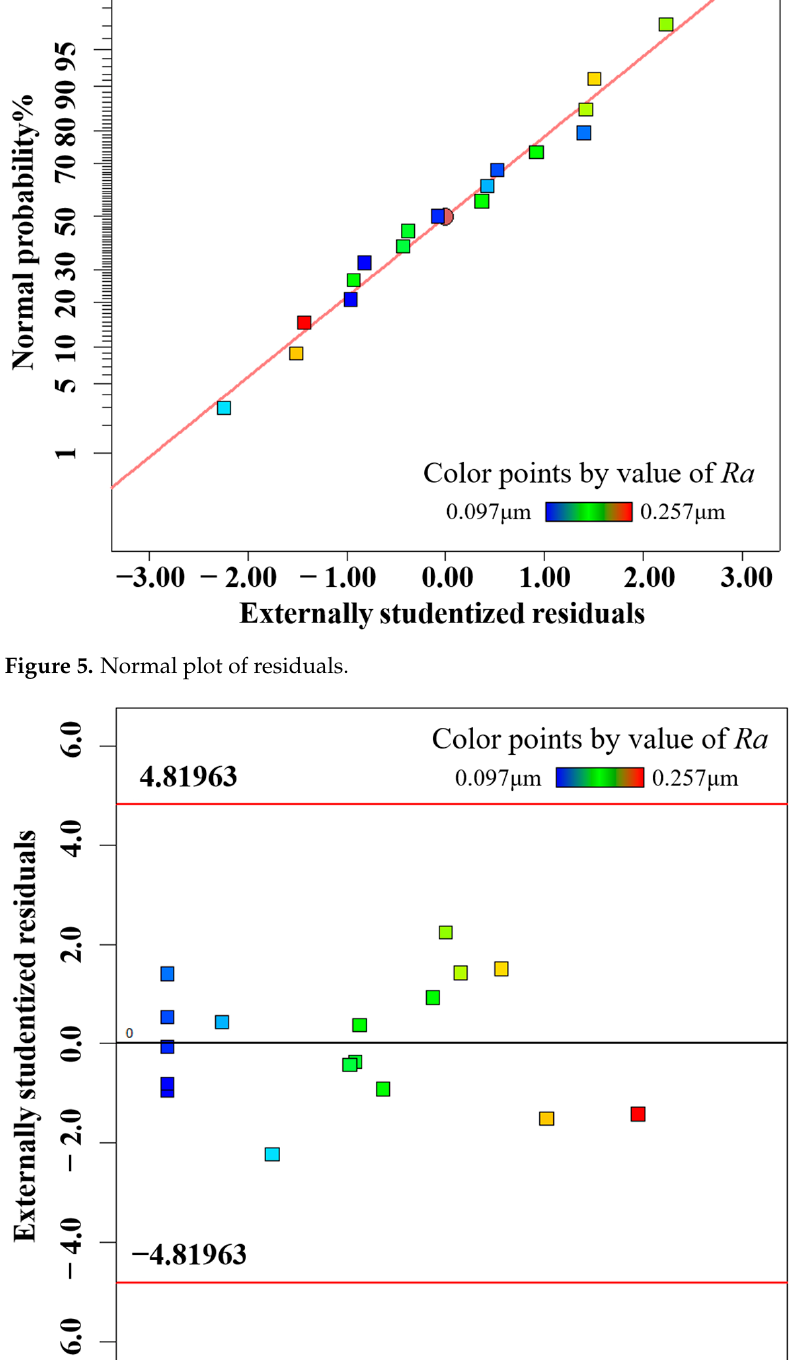
. Figure 7. Plot of predicted versus actual values. 5.3. Response Surface Analysis Based on the secondary response surface mathematical model of tube rotation veloc- ity, magnet feed velocity, and MAPs filling quantity, controlling a single response factor constant, the influence of the remaining response factors on the surface roughness is